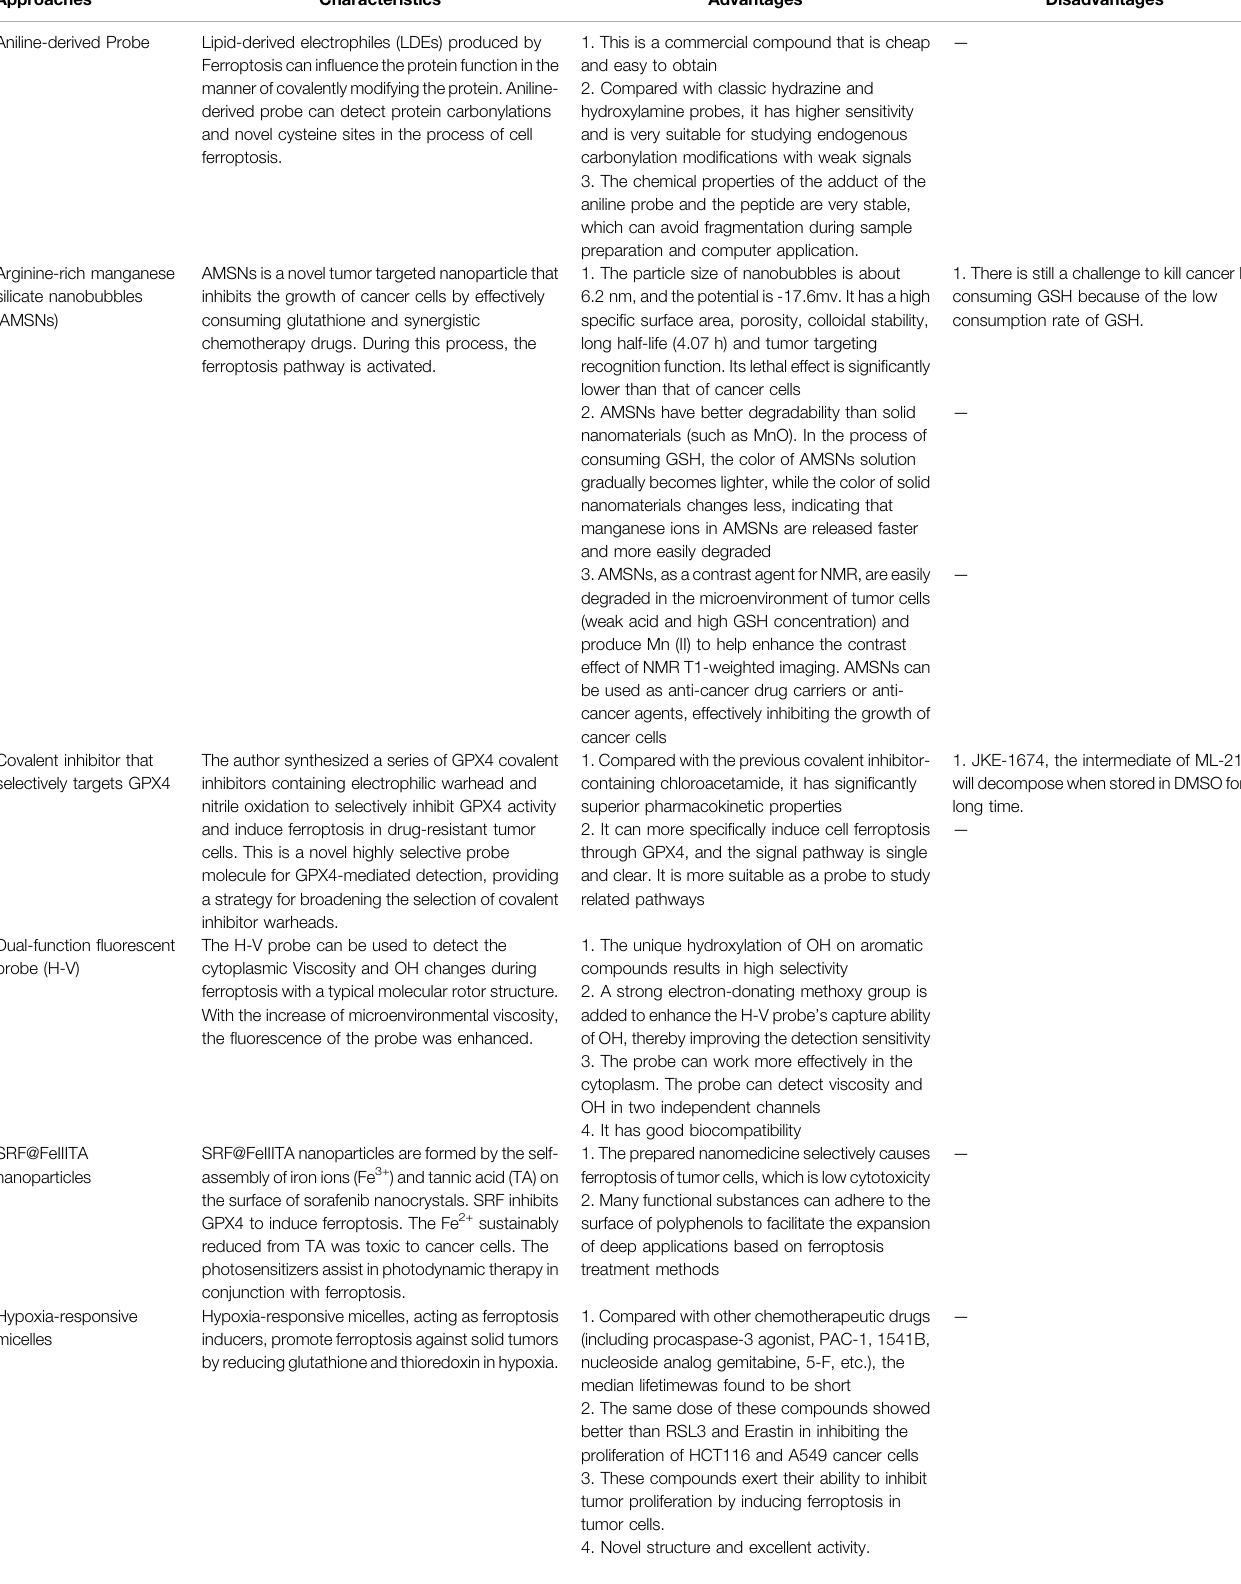
TABLE 1 | Introduction of the more innovative methods and their respective advantages and